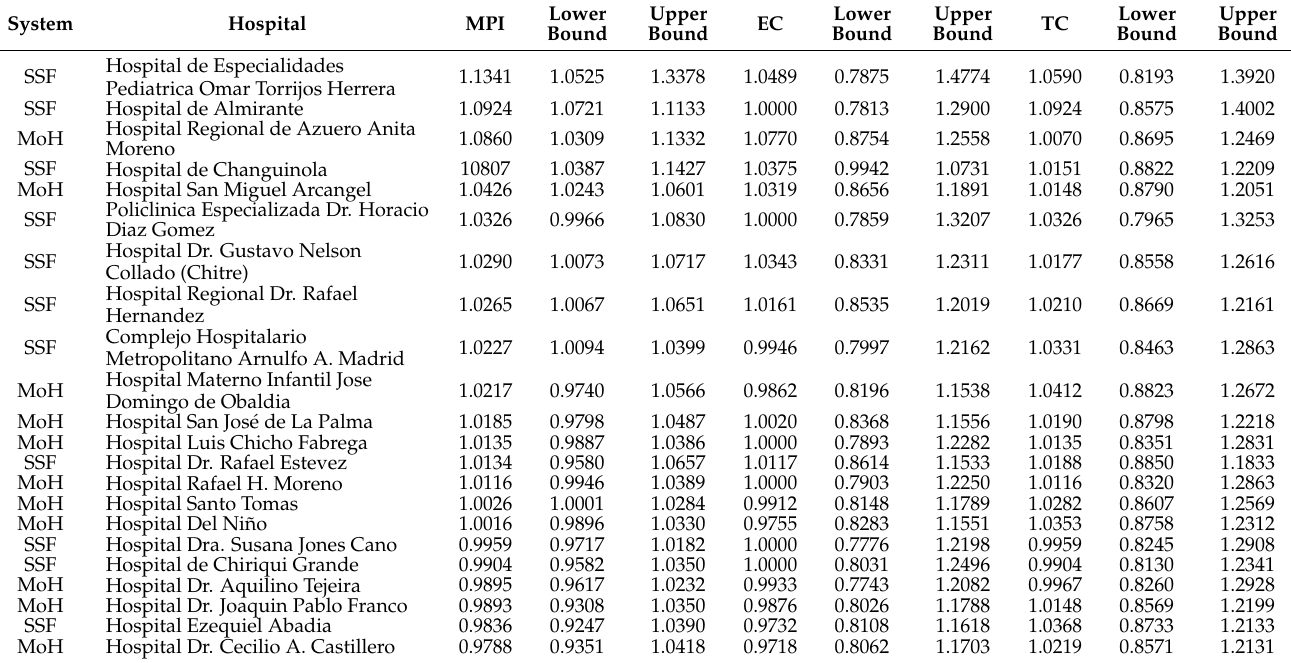
Table 8. Mean values of MPI and their components for each hospital